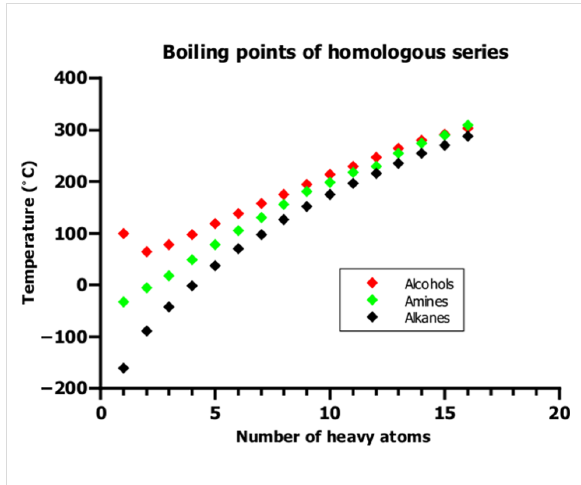
Figure 9: Boiling points of straight-chain primary alcohols, straight- chain primary amines and straight-chain alkanes. Heavy atoms are C, N or